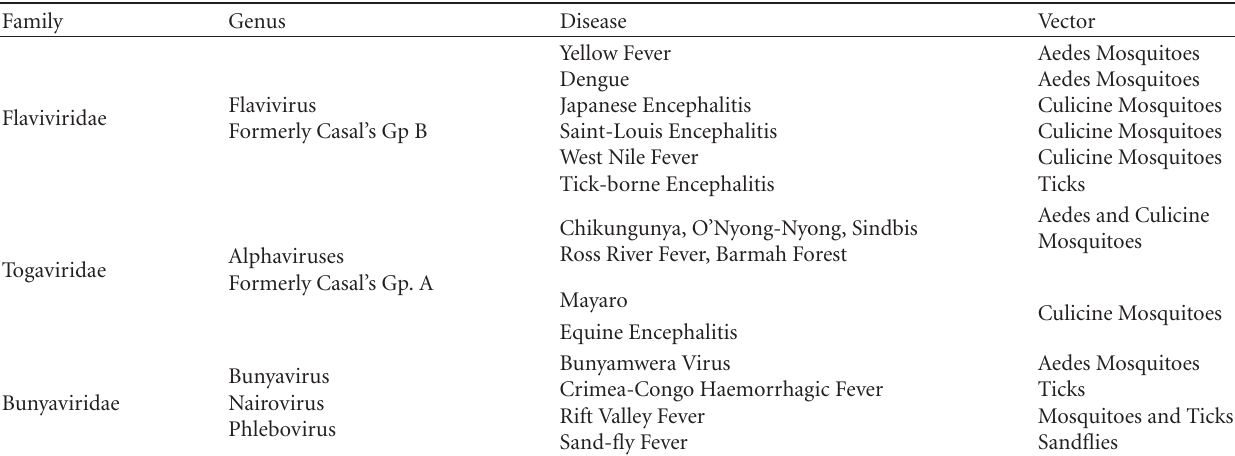
Table 4: Classification of